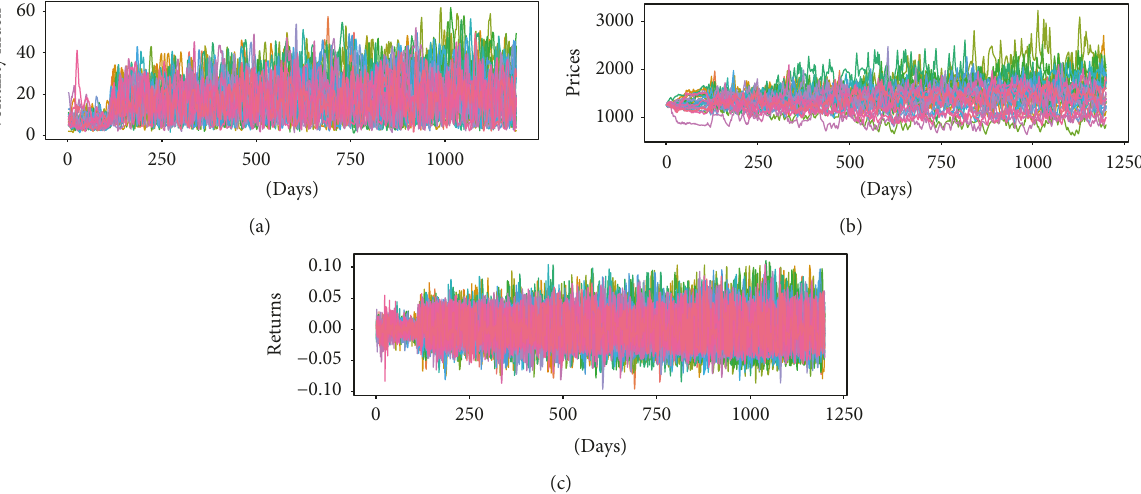
Figure 10: Time series of volatility index (a), prices (b), and returns (c) when 𝑔 = 3 = 0 and 𝑔 = 1 = 𝑔 = 2 = 0 .